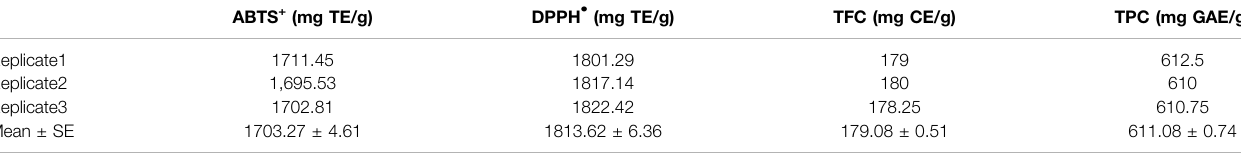
TABLE 2 | Antioxidant contents and activities of ethanolic extract of Tamarindus indica